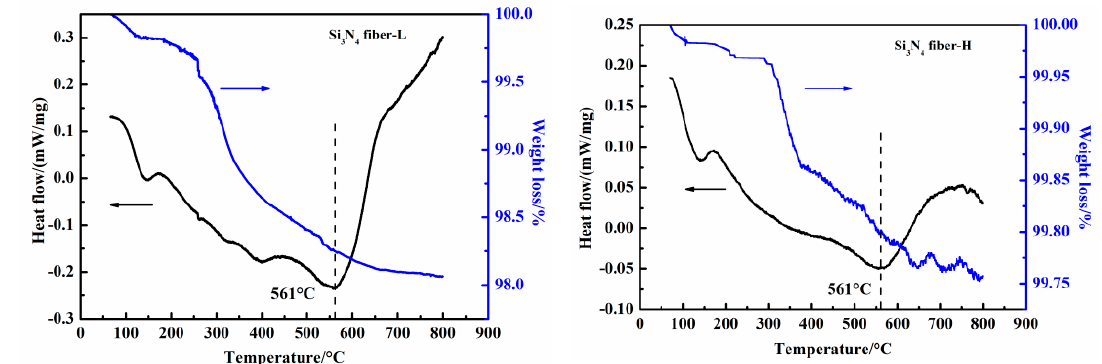
Figure 5. Thermogravimetric and differential scanning calorimeter (TG-DSC) plots of two as-received fibers under Ar atmosphere.